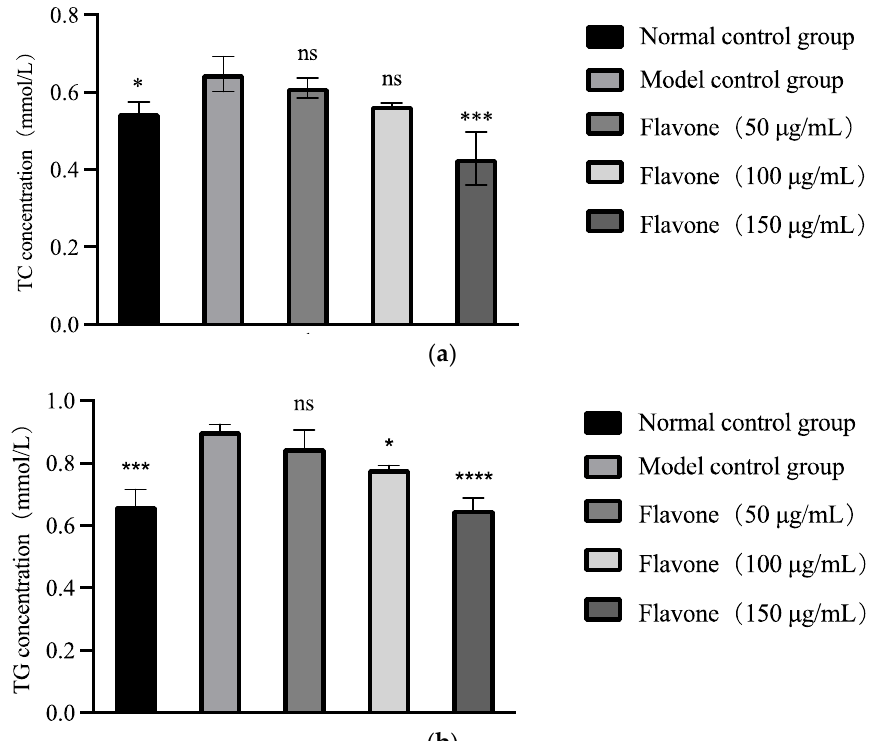
Figure 2. Changes of TC ( a ) and TG ( b ) values in HepG2 cells after treatment of FEAK. Compared with the model control groups, * p < 0.05, *** p < 0.001, **** p < 0.0001.